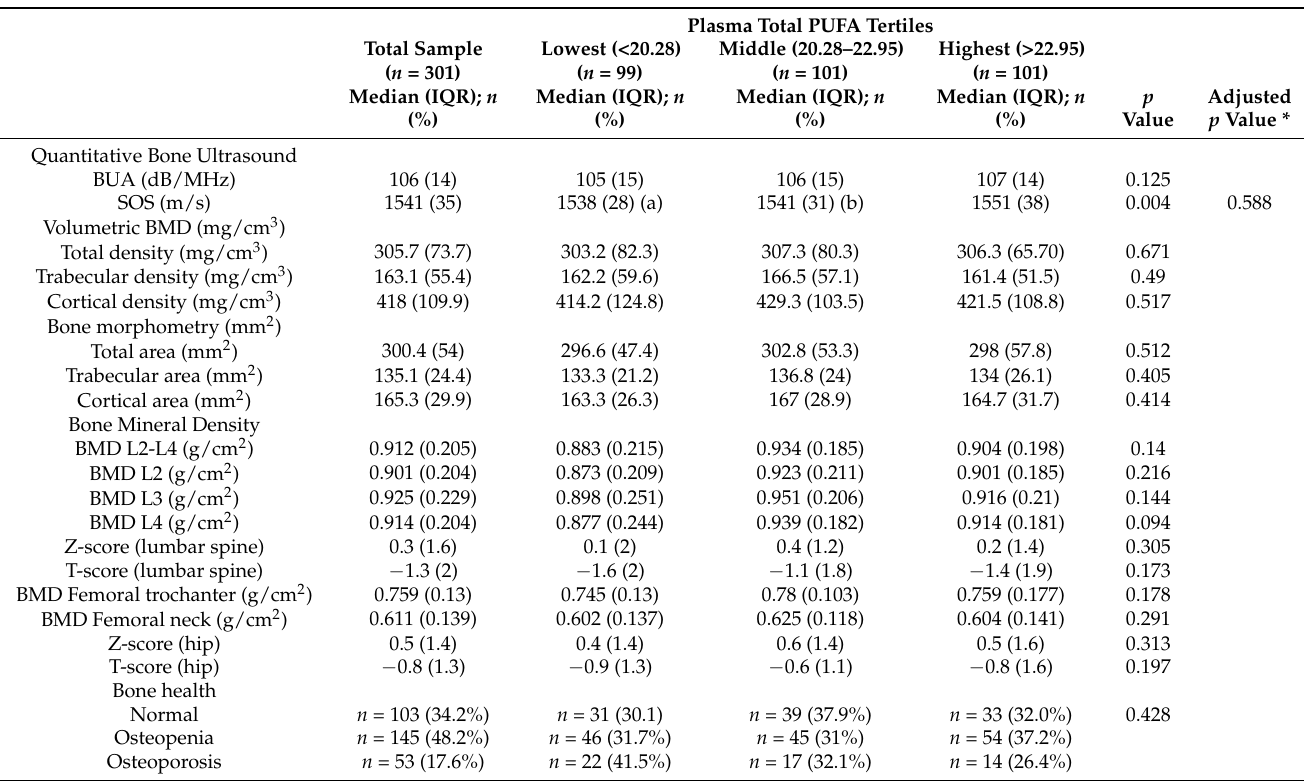
Table 8. Bone parameters by tertile of total plasma